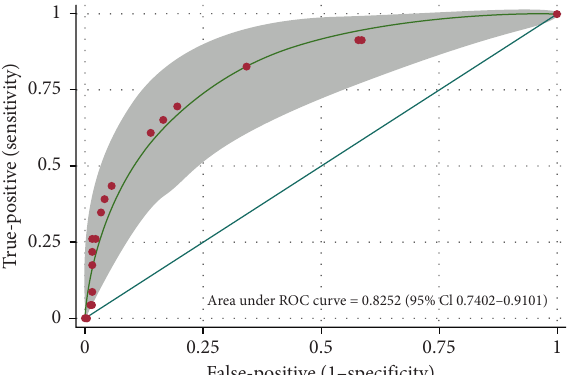
Figure 2: Area under the receiver operating characteristic (AUROC) curve of the clinical risk score and 95% confidence interval (95% CI) for the prediction of cervical spine fracture.